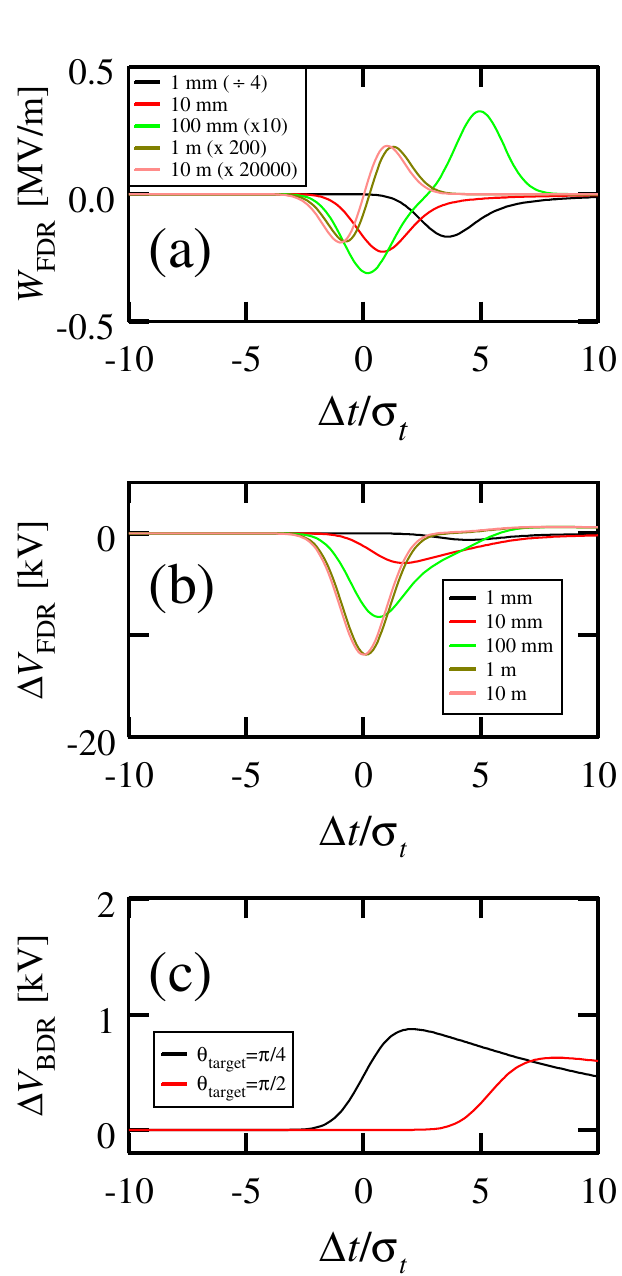
FIG. 4. (Color) Coherent diffraction-radiation (CDR) wakes of a slit between two blades with offsets of 2 mm and outer radii of 20 mm, for a 511-MeV 200-pC Gaussian bunch with (cid:3) z ¼ 400 (cid:9) m and r b ¼ 0 : 1 (cid:3) z . (a) Forward diffraction-radiation (FDR) wake at five distances downstream of the target. (b) Integrated FDR wake at the same five distances. (c) Integrated wakes of backward diffraction radiation (BDR) for two target